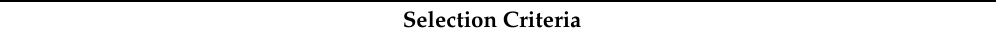
Table 2. Category formulation selection criteria (Source: